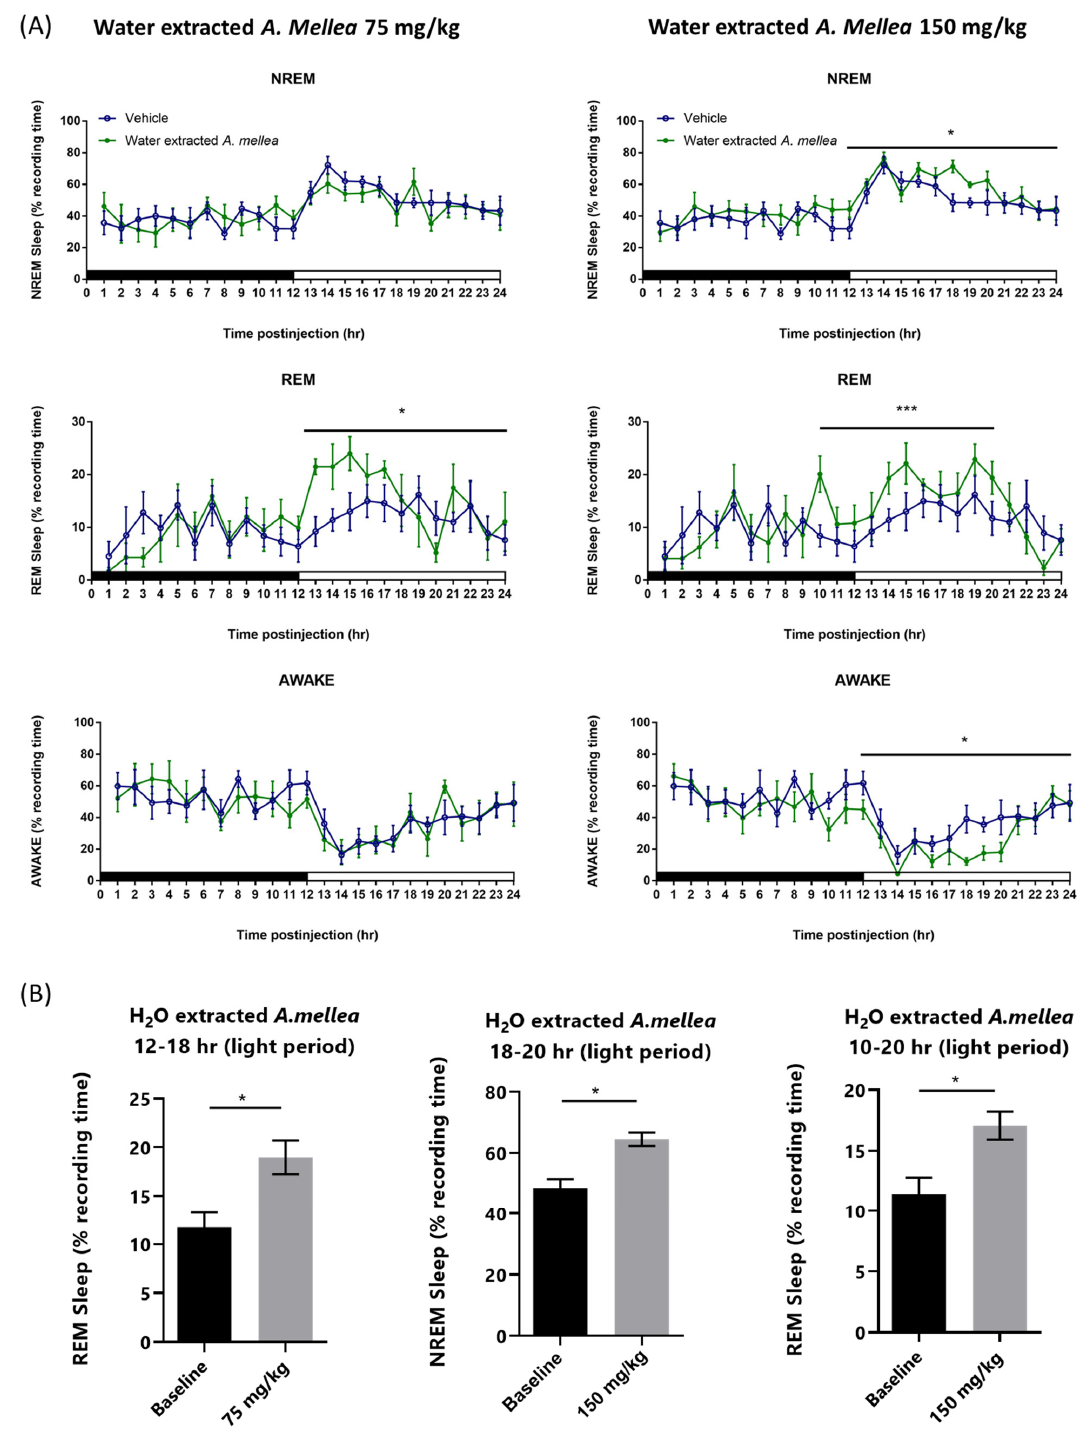
Figure 1. Water extracted A. Mellea increased NREM and REM in rats. ( A ) Time-course changes and ( B ) total amounts of REM, NREM sleep and awake produced after oral administration of water extracted A. Mellea at 75 mg/kg and 150 mg/kg. Open and closed circles stand for the profiles of vehicle and A. Mellea treatments, respectively. The x -axes indicate the 12 h dark (the black bar) and 12 h light periods (the white bar). Values are means ± SEM ( n = 6). * p < 0.05 and *** p < 0.001 indicate significant differences compared with the vehicle